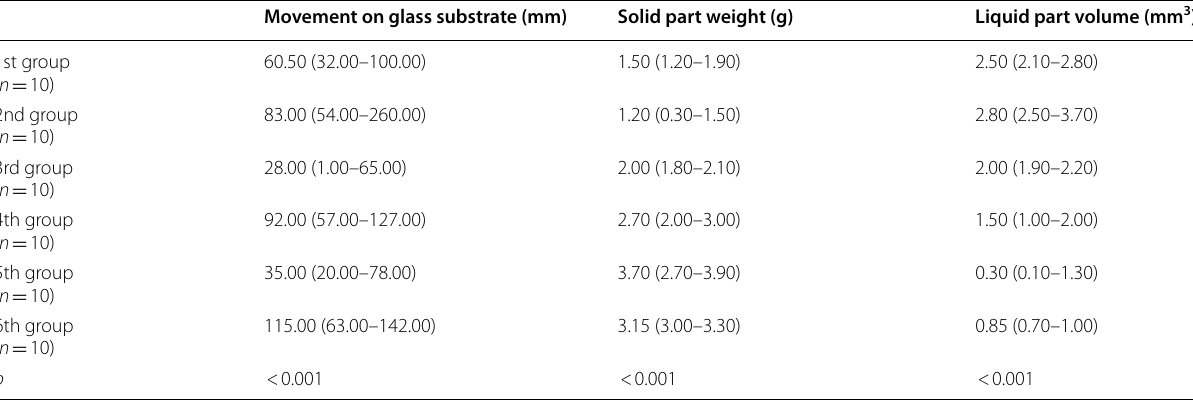
Table 1 Comparison of working groups on movement on glass substrate, solid part weight, and liquid part